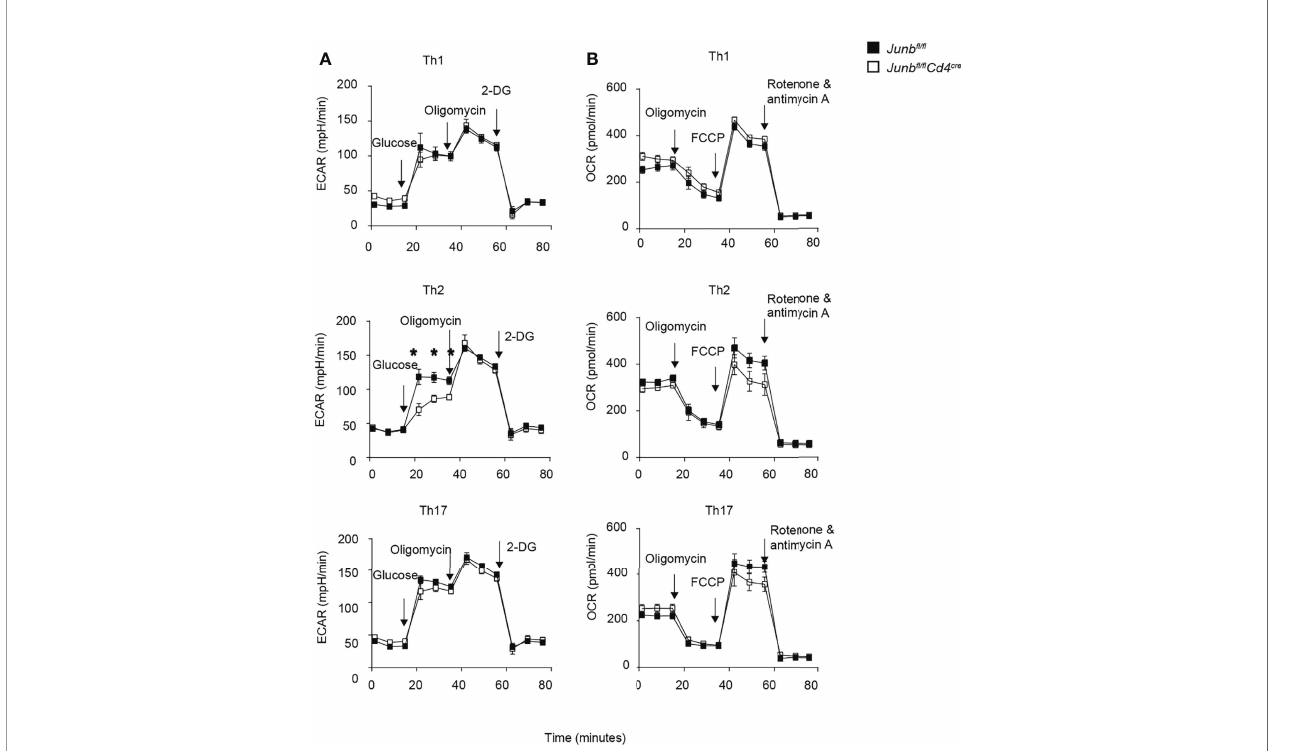
FIGURE 5 | Metabolic reprogramming in Junb -de fi cient CD4 + T cells. Naive CD4 + T cells isolated from Junb fl / fl or Junb fl / fl Cd4 Cre mice were cultured under Th1-, Th2- and Th17-polarizing conditions. After 48 h, extracellular acidi fi cation rate (ECAR) (A) and oxygen consumption rate (OCR) (B) were measured using a Seahorse analyzer. During ECAR measurement, cells were sequentially treated with glucose, oligomycin, and 2-DG. During OCR measurements, cells were sequentially treated with oligomycin, fl uorocarbonyl cyanide phenylhydrazone (FCCP), rotenone, and antimycin (A) Error bars indicate s.e.m (n = 6 wells per group). * p < 0.05, (unpaired two-tailed Student ’ s t-test). Data represent two independent